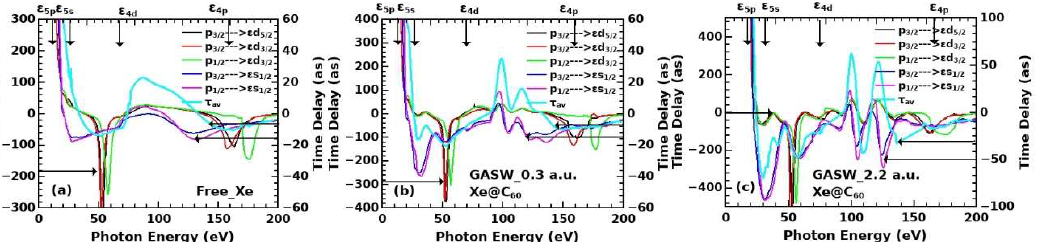
Figure 14. Time delay of photoionization from the 5p subshell of ( a ) free and confined Xe using the depths of ( b ) 0.3 a.u. ( middle panel ) and ( c ) 2.2 a.u. ( right panel ). Left and right axes are the time scale of the p → ε d and p → ε s channels, respectively, which are indicated by the horizontal arrows. The average time delay ( τ av ) is also linked to the right axis. Vertical arrows indicate the threshold 5 p values of the corresponding subshells used in the